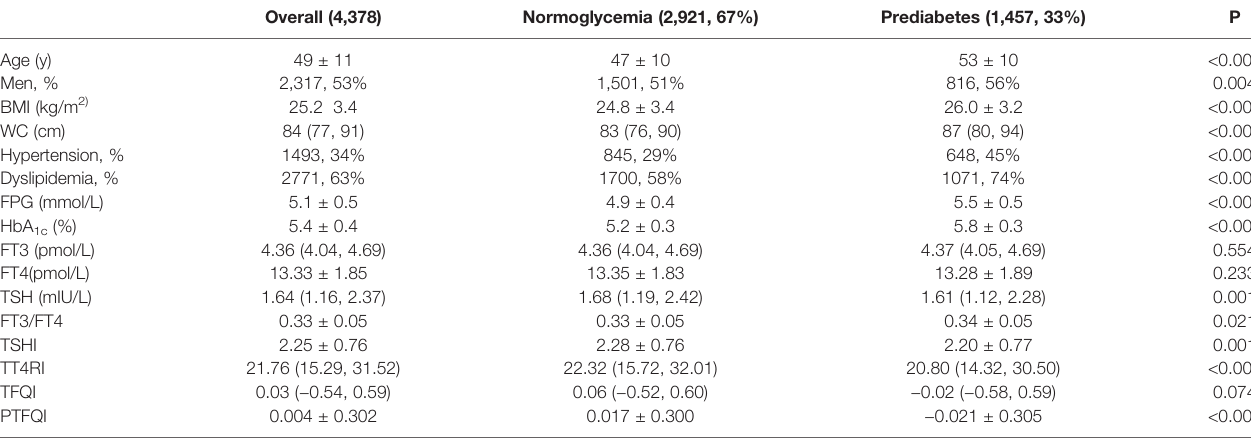
TABLE 1 | Baseline characteristics of participants with normoglycemia and